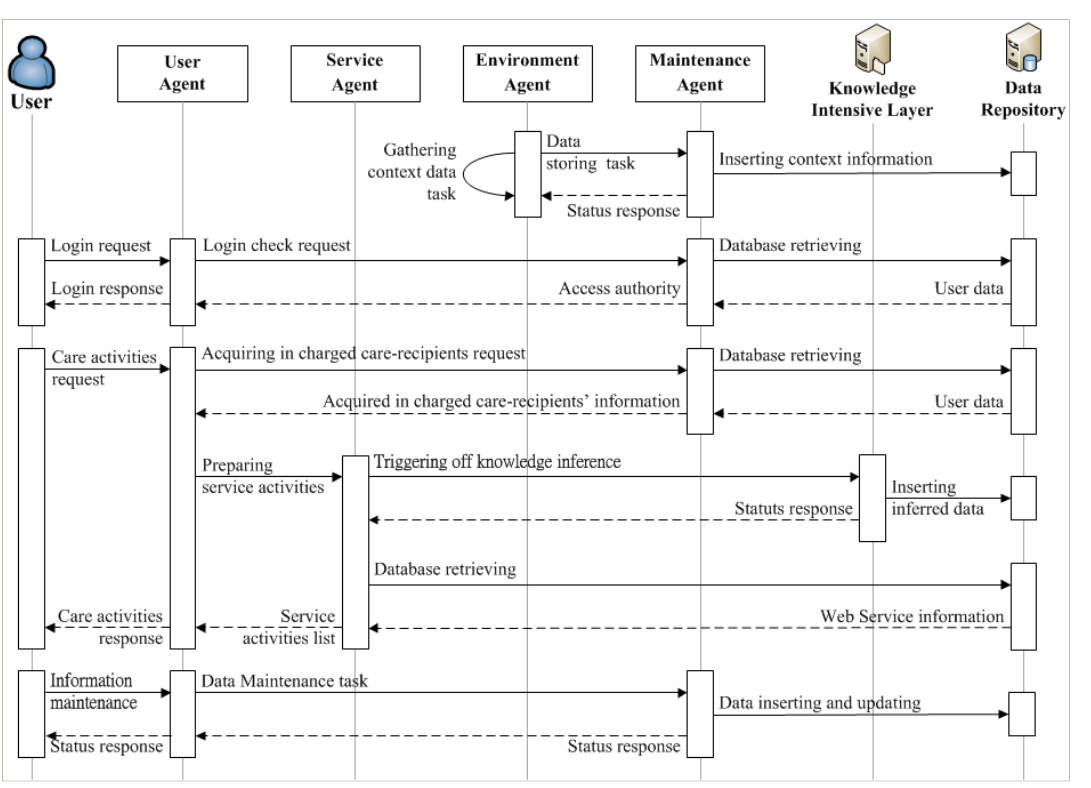
Figure 9. Interactions among agents, knowledge intensive layer, and data